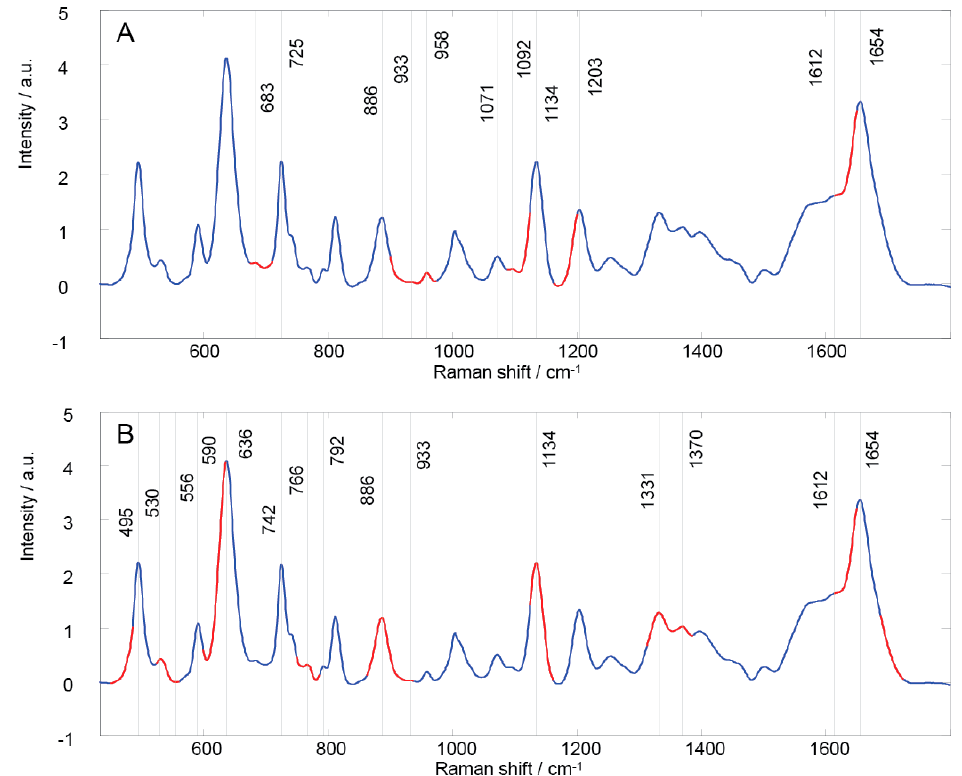
Figure 3. The most informative SERS spectral bands and regions as selected by GA for differentiation between: ( a ) AD (all stages) and HC serum samples and ( b ) AD (all stages) and OD serum samples. Selected regions are depicted in red on the average SERS pattern for serum of all classes in order to make comparisons.